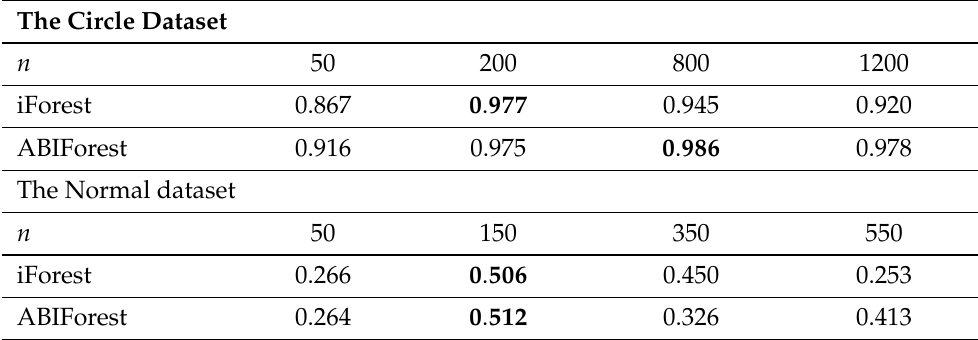
Table 6. F1-score measures of the original iForest and ABIForest as functions of the training data number n for the Circle and Normal